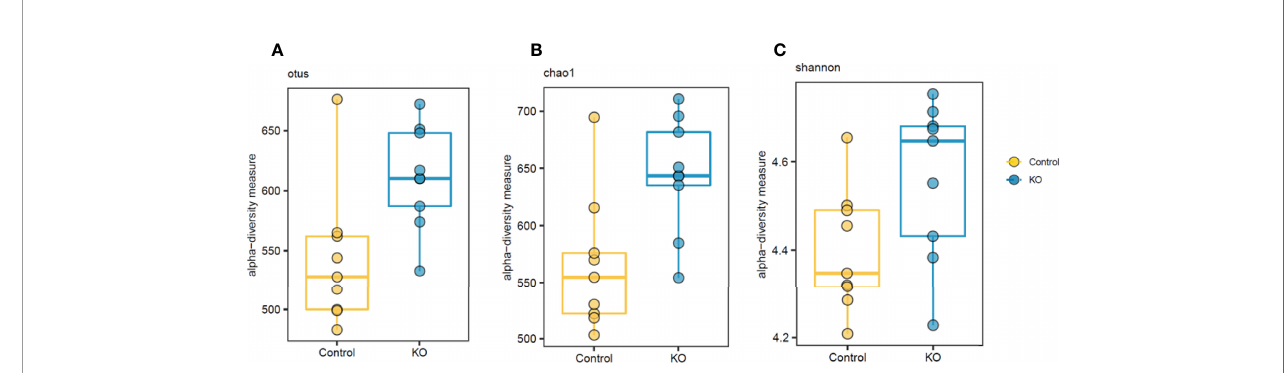
FIGURE 2 | Differential a -diversity levels in NHE3 IEC-KO and control mice. a -diversity analysis suggests signi fi cant differences in otus (A) and chao1 (B) richness estimators and Shannon diversity ( P < 0.05) (C) between NHE3 IEC-KO and control mice (Mann-Whitney test). N = 9/genotype.